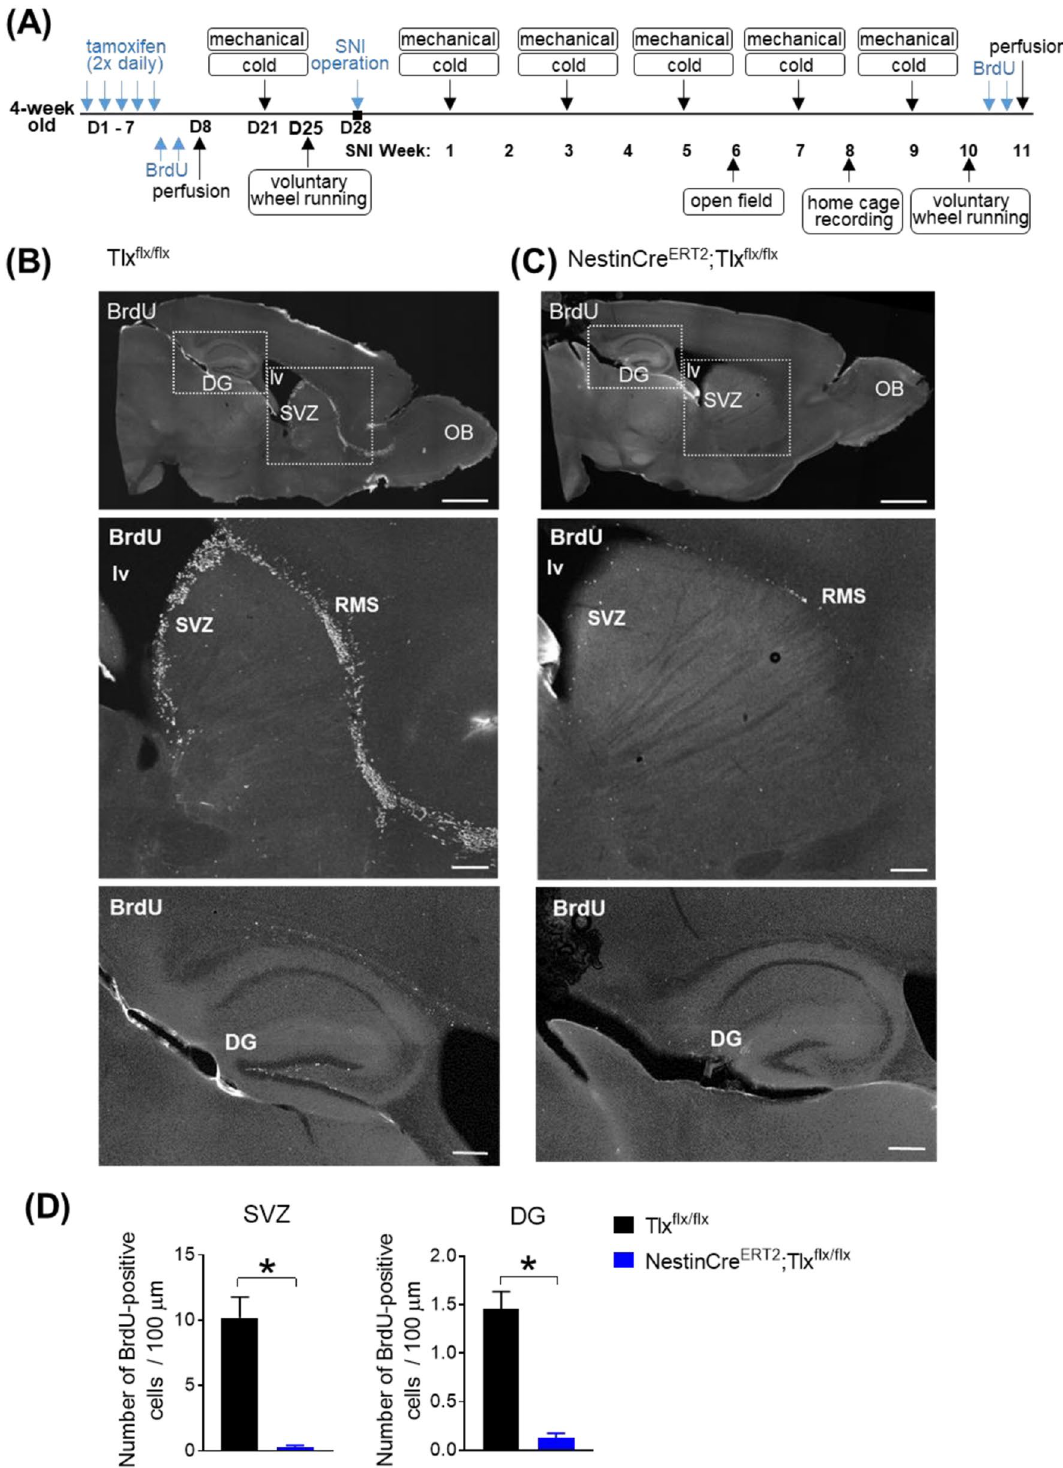
Figure 1. ( A ) Scheme of experimental timeline of injections, nerve operation and behavioural assessments carried out over the course of 15 weeks. ( B–D ) On experimental Day 8, neurogenesis (indicated by BrdU-labelled cells) in the SVZ and DG of NestinCre ERT2 ;TIx flx/ flx mice is abolished after Tamoxifen injections (twice daily over 5 consecutive days) followed by BrdU administration (once daily for 2 days after Tamoxifen administration to label proliferating cells). ( B,C ) Example images of sagittal whole brain sections (upper row; scale bar, 1 mm) with BrdU-labelled cells (in white) present along the rostral migratory stream (RMS) of control cre-negative TIx flx/flx mice (in ( B )) after Tamoxifen injections. BrdU-labelled cells are largely absent along the RMS of cre-positive NestinCre ERT2 ;TIx flx/flx mice (in ( C )) after Tamoxifen injections. Higher magnification of regions indicated in the dotted box are shown in the lower panels (scale bar, 200 pm). ( D ) Average number of BrdU-positive cells (per 100 pm) present in the SVZ (left) and DG (right) of either cre- negative or cre-positive NestinCre ERT2 ;TIx flx/flx mice, 1 week after Tamoxifen injection (experimental Day 8; n = 5–6/group; * p < 0.05, unpaired I-test). OB olfactory bulb, lv lateral ventricle, DG dentate gyrus, SVZ subventricular